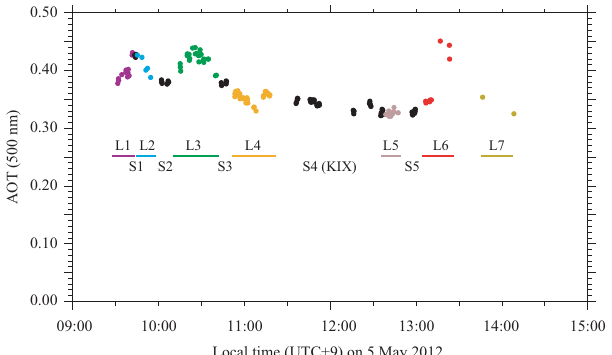
Figure 6. The values of AOT (500nm) measured with Microtops- II by car on 5 May. Each color of the filled circles represents the corresponding color of the transect path in Fig. 4. The black filled circles indicate the measurements of AOT at the stopping points, S1 to S5.